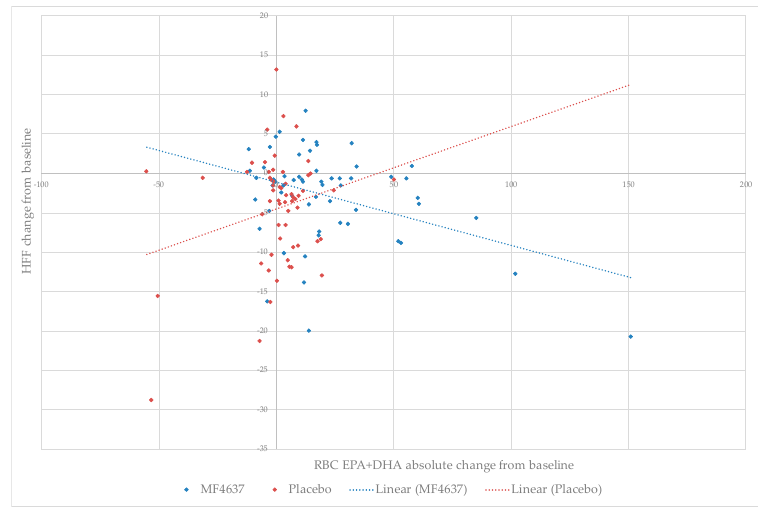
Figure 2. Relationship between change in absolute RBC EPA + DHA and change in liver fat.